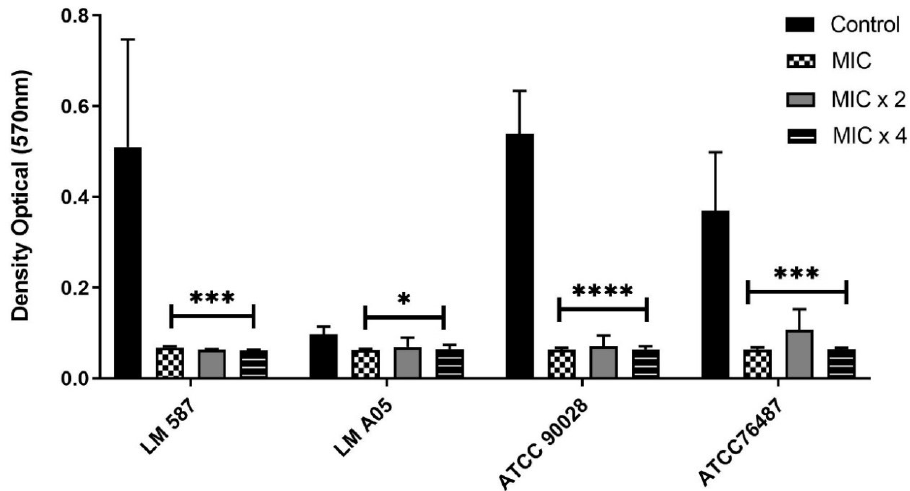
Figure 3. Rupture of mature C. albicans biofilm after exposure to different concentrations of α -pinene. * p < 0.05; *** p < 0.001; **** p < 0.0001 as compared to the control group. MIC: Minimum Inhibitory Concentration; LM: from the UFPB Mycology Laboratory.